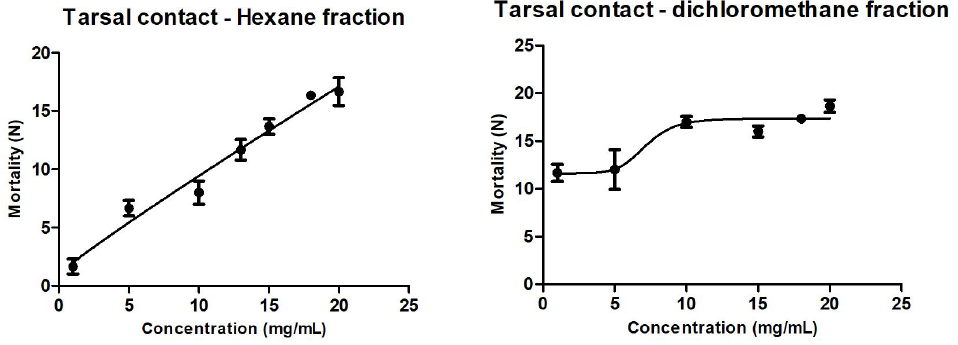
Figure 6. Dose-response curve of mortality (n) of Aedes aegypti adult (tarsal contact) versus concentrations (mg/mL) of fractions of Helicteres velutina after 48 hours. The LC 50 and LC90 were calculated using non-linear regression, considering a 95% significance level.